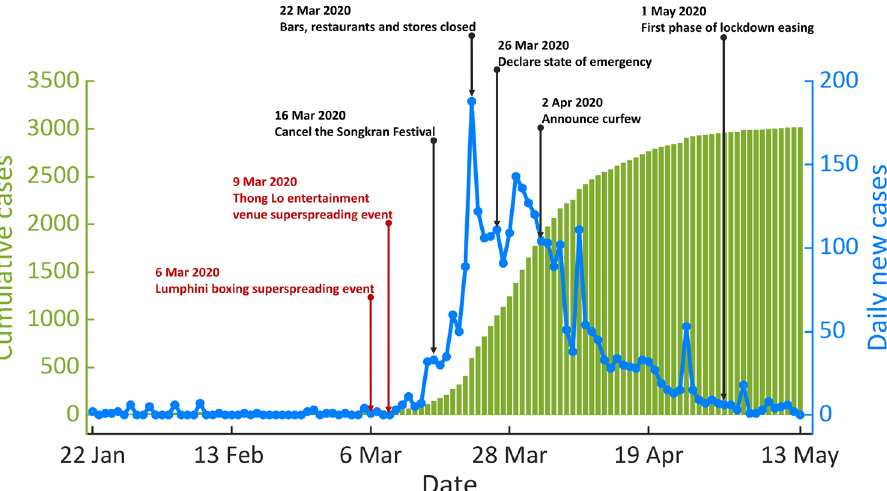
Figure 1. The first wave of COVID-19 outbreak in Thailand. The blue line illustrates the number of daily new locally transmitted cases during the first epidemic wave (from 22 January to 13 May 2020). The green bar shows the corresponding number of cumulative cases. The black arrows indicate the time points at which control measures were implemented, while the time points of the large cluster outbreaks are shown using the red